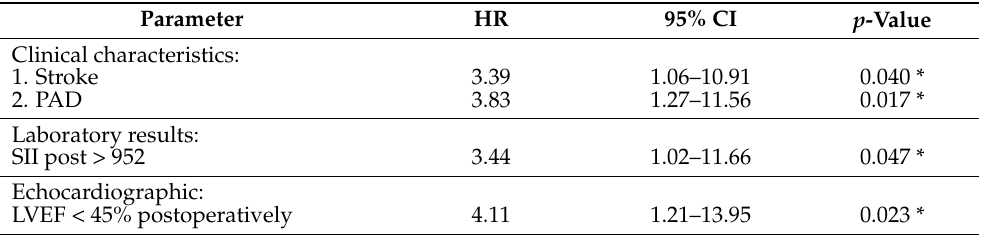
Table 5. Cox regression multivariable